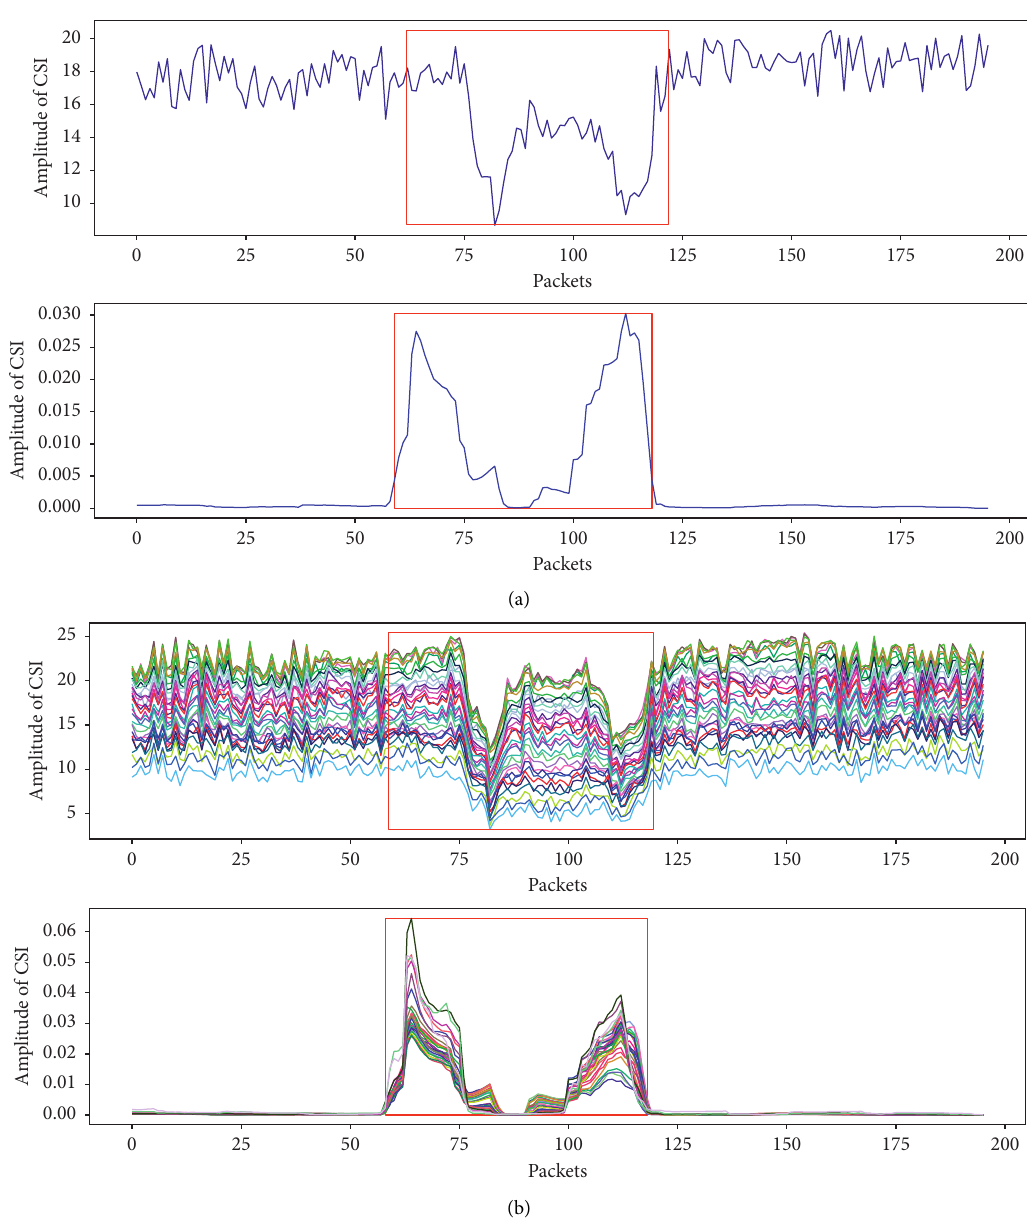
Figure 9: The raw signal and segmented signal of (a) a single subcarrier and (b) all